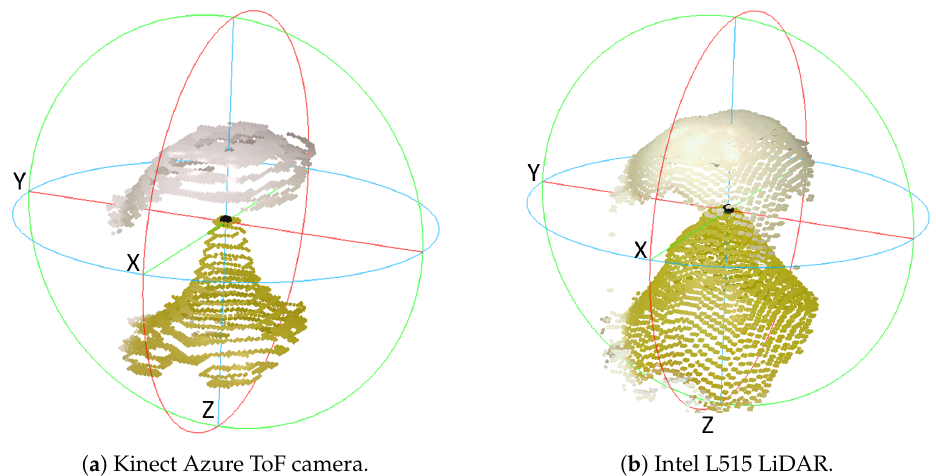
Figure 10. Scans for Kinect Azure ( a ) and Intel L515 ( b ) RGB-D depth scans of a single grape before (green) and after (white) individual grapes had been painted with white spray paint. Note that the Z -axis direction shown in the plots is the depth axis. The cameras were located 350 mm from the grapes. The Kinect Azure and Intel L515 have their unpainted peaks respectively about 7 mm and 8.5 mm behind the painted peaks. The Azure scan is more heavily quantised than the L515